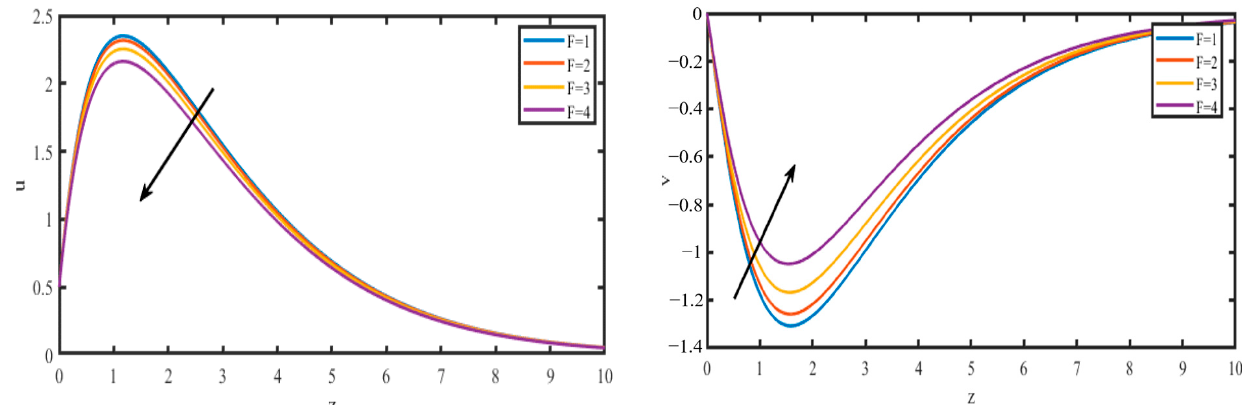
Figure 7. The velocity patterns for u and v plotted vs. m, with k = 0.50, R = 1.0, Gr = 5.0, S = 1.0, Gm = 3.0, M = 2.0, Pr = 0.710, H = 1.0, Sc = 0.220, Kc = 1.0, n = 0.50, t = 0.50, So = 0.50, F = 1.0.